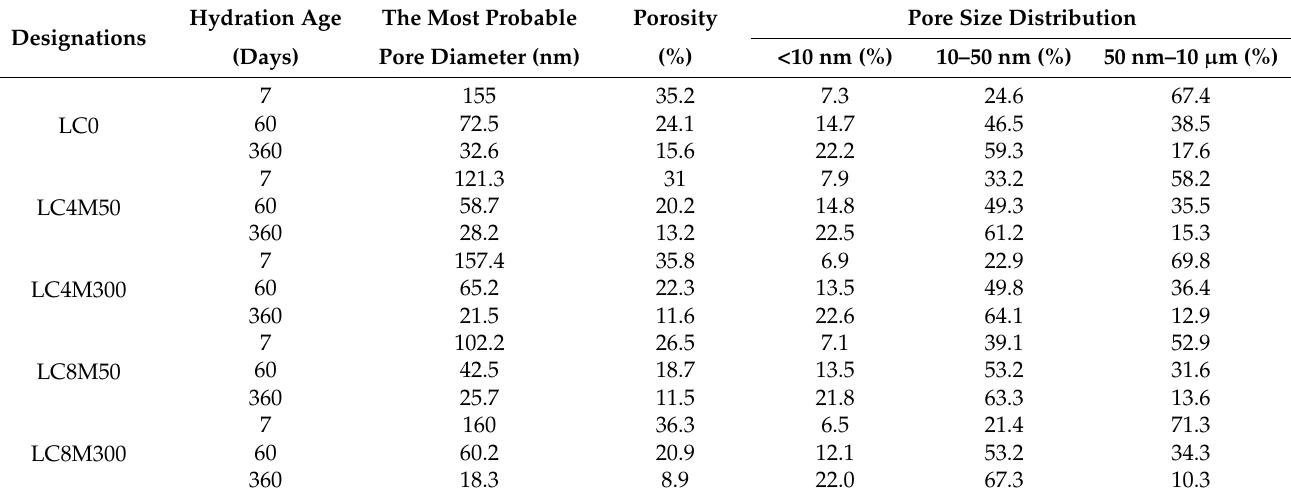
Table 4. Pore structure parameters of concrete obtained by